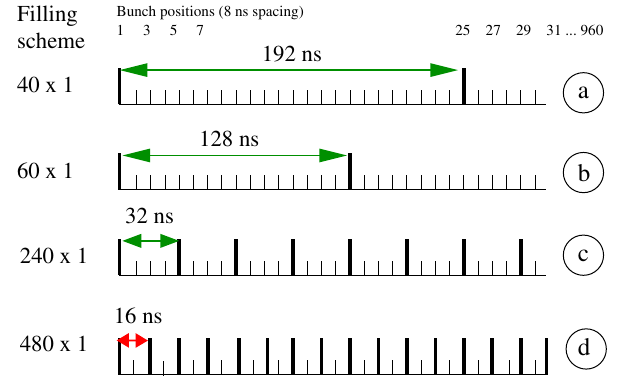
FIG. 2. Bunch filling schemes of PETRA III for the user runs in 2011 (a)–(c) and for the scrubbing run in March 2012